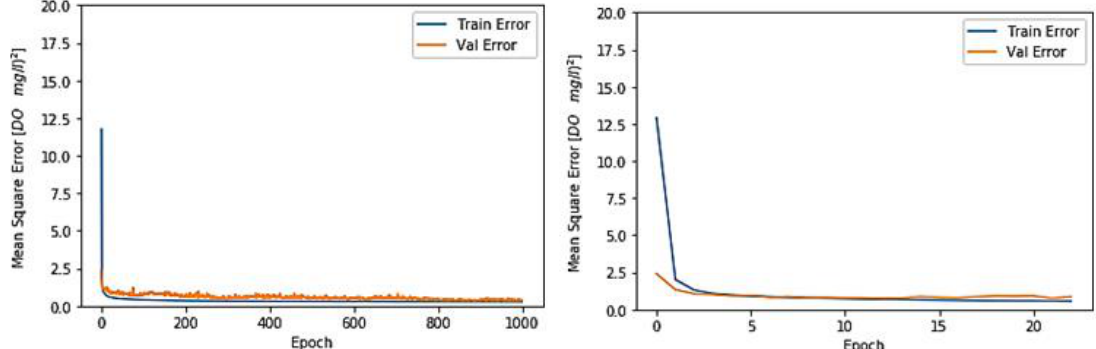
Figure 9. Mean absolute error (Toichio station, structure 7-32-32-1).